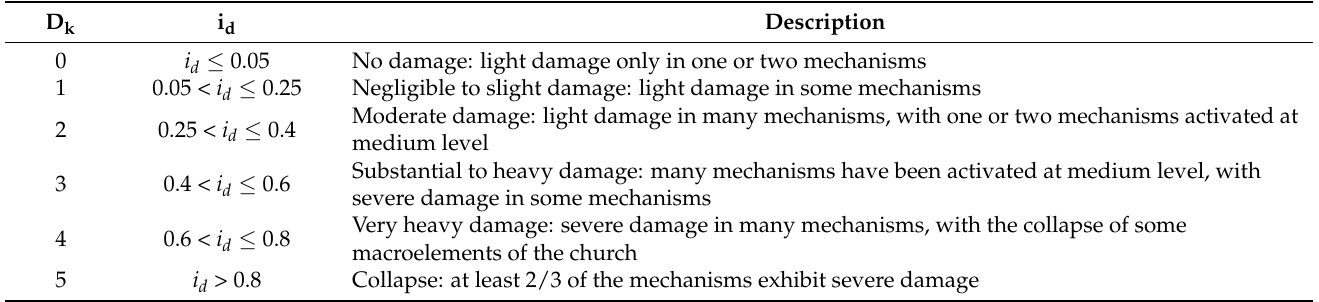
Table 3. Definition of structural damage levels for the churches, based on the damage score.